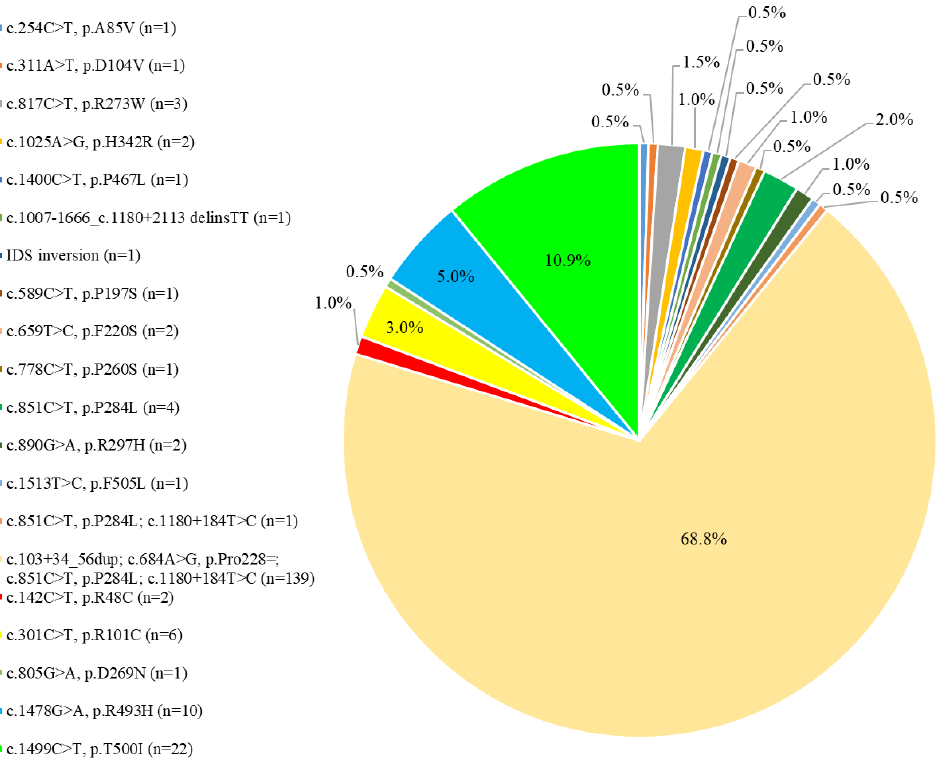
Figure 2. The numbers and percentages of the 21 IDS gene variants identified in the 202 infants in our MPS II newborn screening program.